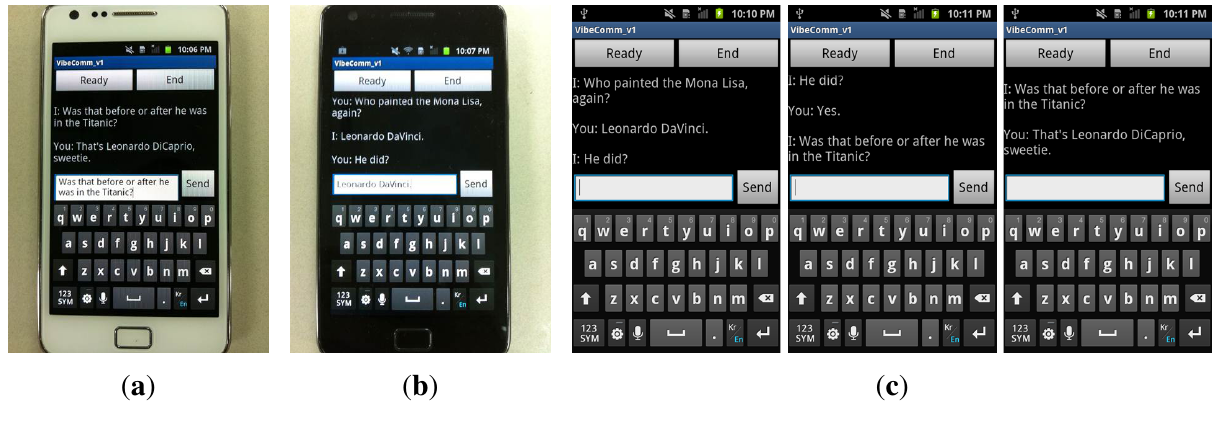
Figure 17. One-to-many communication using VibeComm . Upon receiving a command from the transmitter on the left, the receiving devices change their background simultaneously from the blank initial background to the background shown above. ( a ) Initial